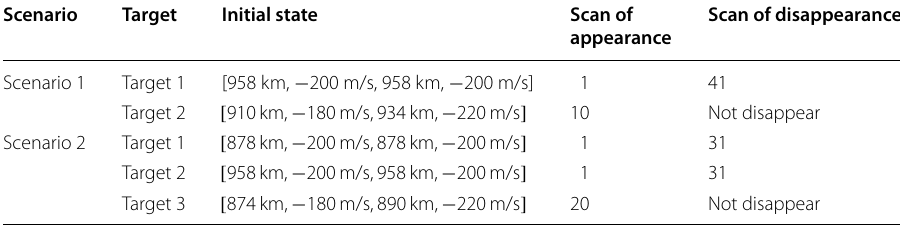
Table 5 Target motion parameters for